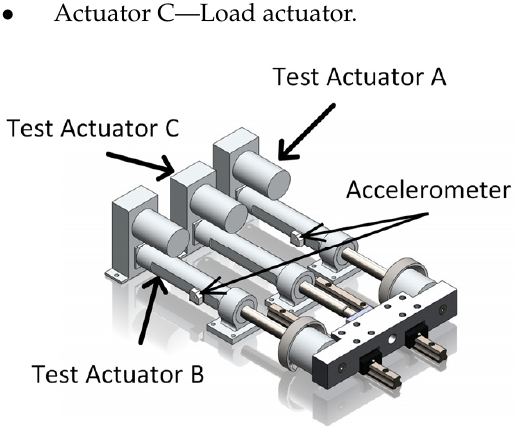
Figure 3. FLEA System. By switching the load actuator from actuator B to actuator A, FLEA enables fault injection without changing the operating state of the EMA system. Additionally, two nut accelerometers were attached to actuators A and B. The ac- celerometers were used to collect vibration data at a sampling frequency of 20 kHz. In Figure 4, it is shown that the accelerometer was in three different directions (X is in line with the actuator motion, Y is vertical, and Z is horizontal).